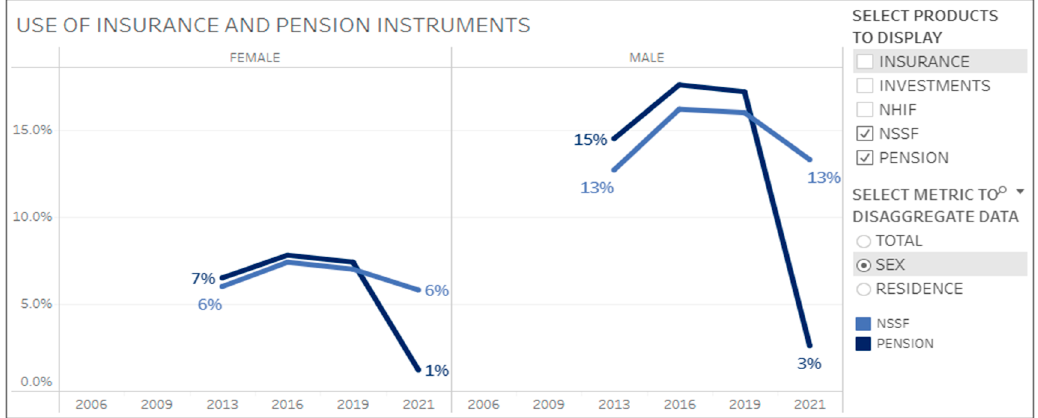
Figure A2. NSSF and other pension uptake by sex. Source: FinAccess Kenya (2022).